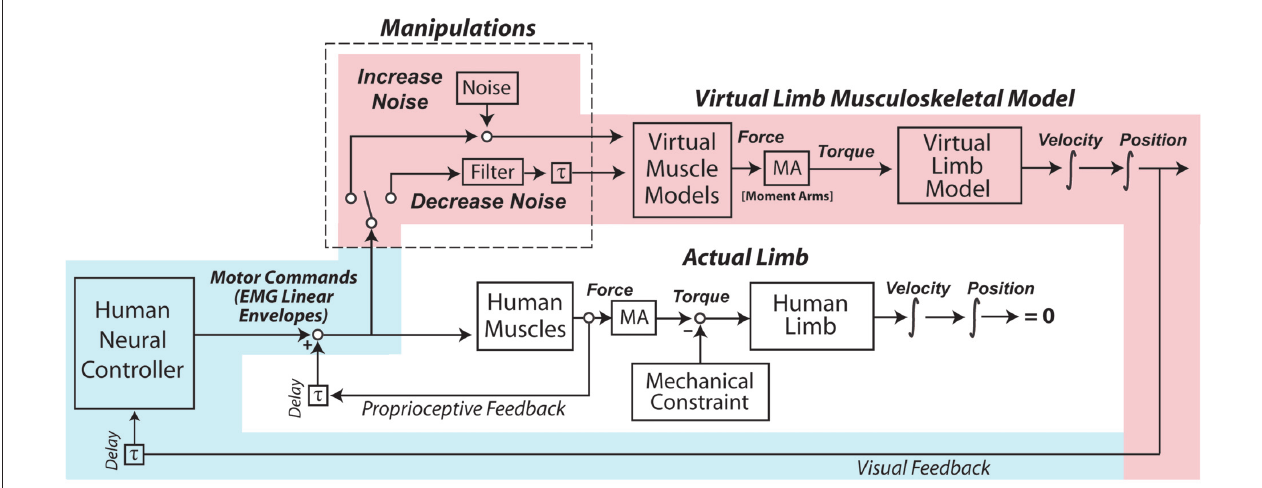
FIGURE 1 | In the experiment, subjects used their muscle activity to perform a goal-directed task with a virtual arm. After a period of familiarization, the coefficient of variation (CV) of subjects’ motor commands (as reflected by muscle activity linear envelopes) was increased by adding signal-dependent noise, and in another condition the CV was decreased with an exponentially-weighted moving average filter. The shading highlights the control loop hypothesized to take precedence in the virtual arm task, with processes associated with human physiology shaded in light blue, and processes in the virtual world shaded in light red. Note that during the experiment the actual human arm does not move due to an external mechanical constraint, and although subjects received proprioceptive feedback about their actual arms, this feedback did not reflect the actions of the virtual muscles and arm, and therefore was not of high relevance to the task (in contrast to the visual